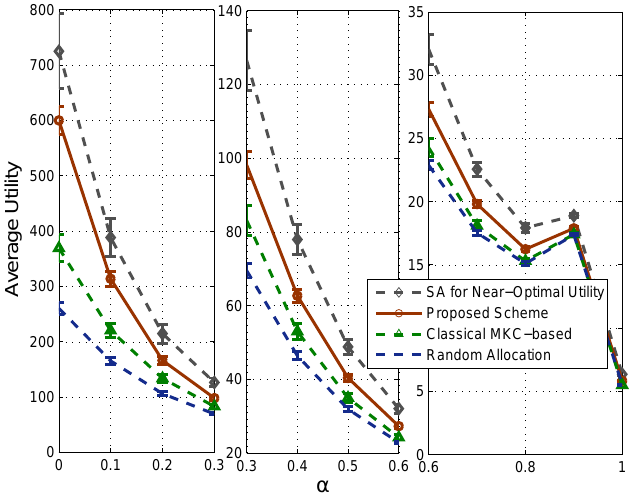
Figure 6. Comparison of